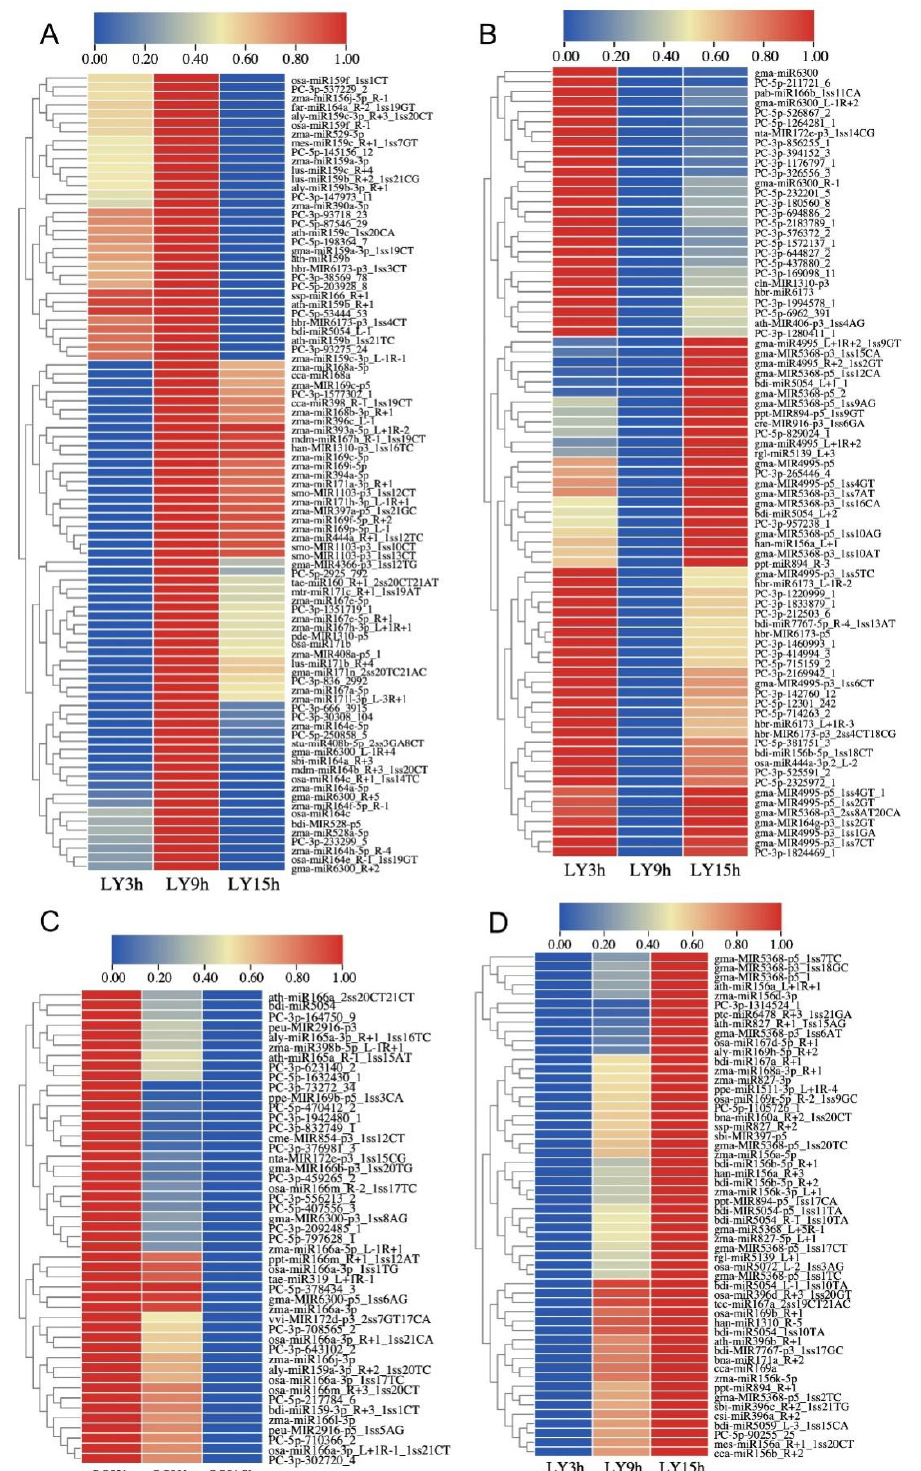
Figure 3. Expression dynamics of miRNAs in response to C. lunata in the resistant variety LY at different inoculation time points (3, 9 and 15 hpi). The expression trends were divided into four categories: first increase and then decrease ( A ), first decrease and then increase ( B ), reduced expression ( C ) and increased expression ( D ).